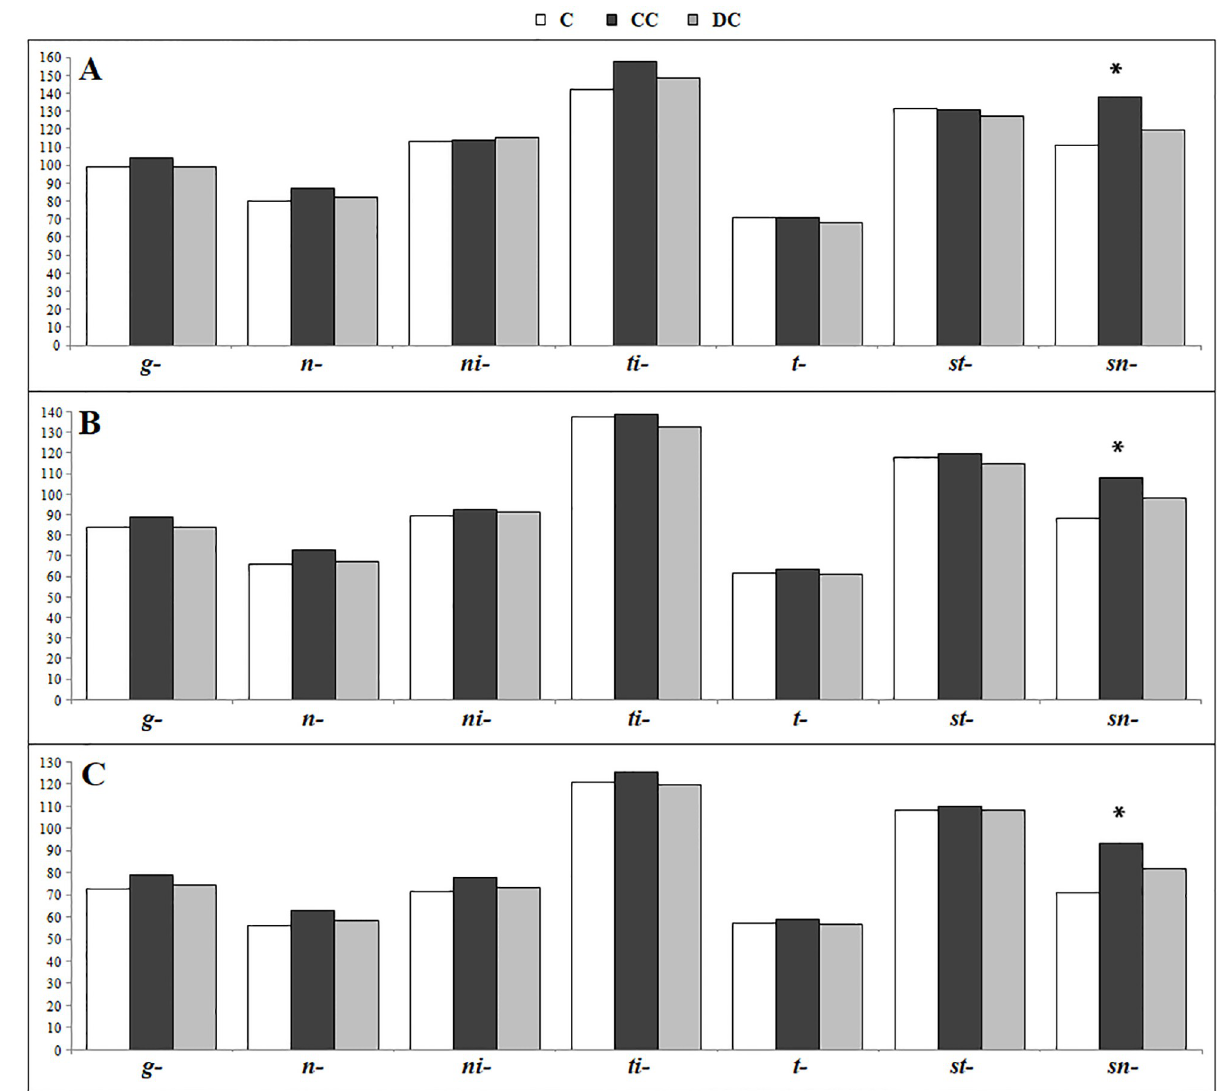
Fig 4. Representative distribution of total RNFL thickness (micron). RNFL thickness in control (C), congenital cataract (CC) and development cataract (DC) groups at 3.5 (A), 4.5 (B) and 4.7 mm (C) of eccentricity; thickness of g- global, in- inferonasal, it- inferotemporal, st- superotemporal and sn- superonasal sectors are shown. � statistically